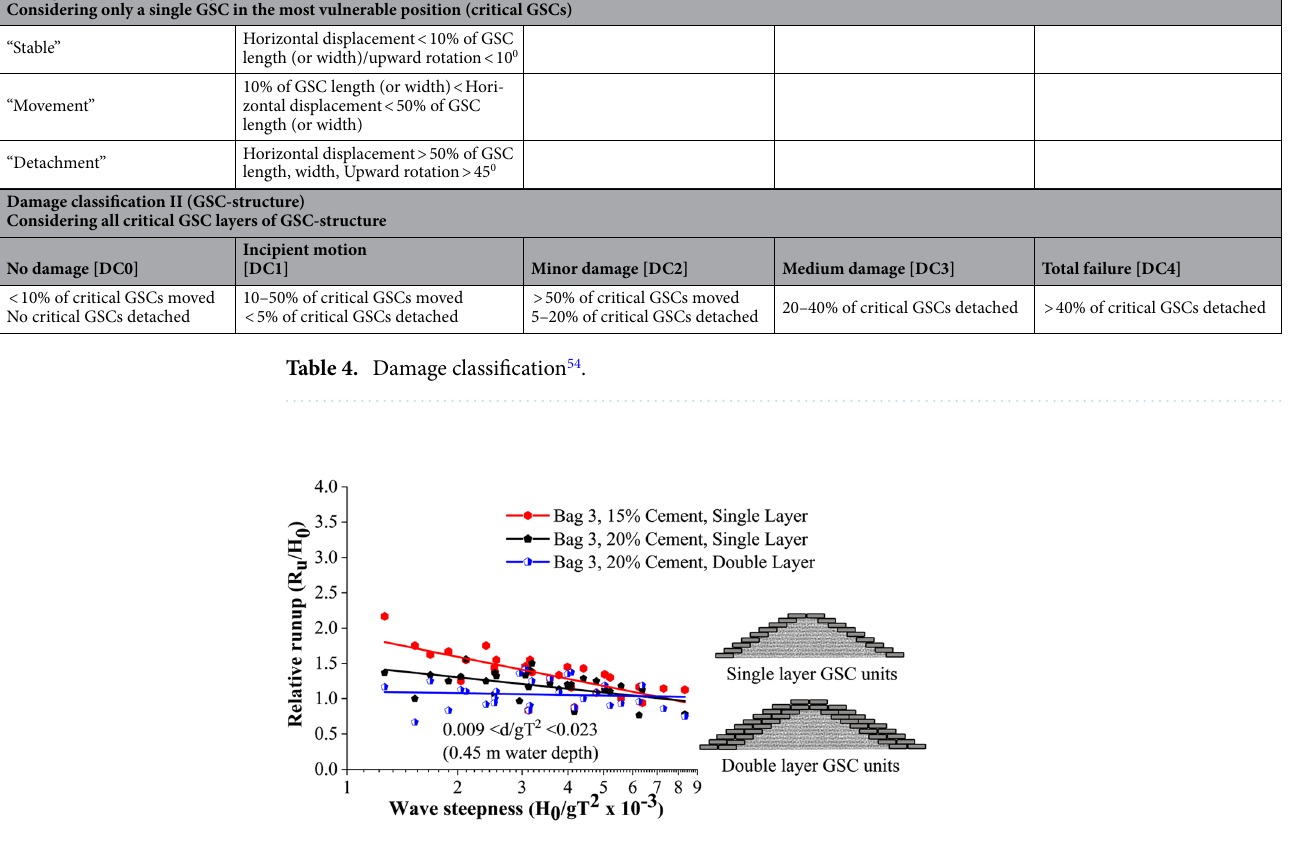
Figure 4. Relative runup of all tested